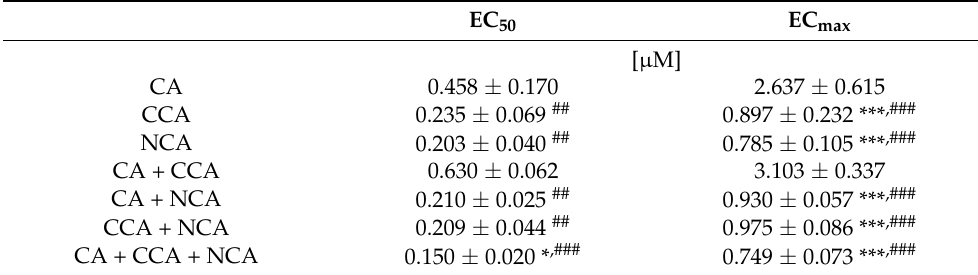
Figure 11. Effects of the major components of PJE on wound healing. ( A ) The migration rates of each CA and their mixtures were calculated, and data from the concentrations of 0.846 μ M and 8.46 μ M are presented as the means ± SD. The relative migration rates of ( B ) each CA individually, ( C ) double CA mixtures and ( D ) the triple CA mixture are presented as the means ± SD; their EC 50 values are indicated by dotted lines. ††† p < 0.001 compared to Con; * p < 0.05, ** p < 0.01 *** p < 0.001 compared to 0 μ g/mL PJE. Table 2. The EC 50 and EC max values of each CA and their mixtures on wound healing.